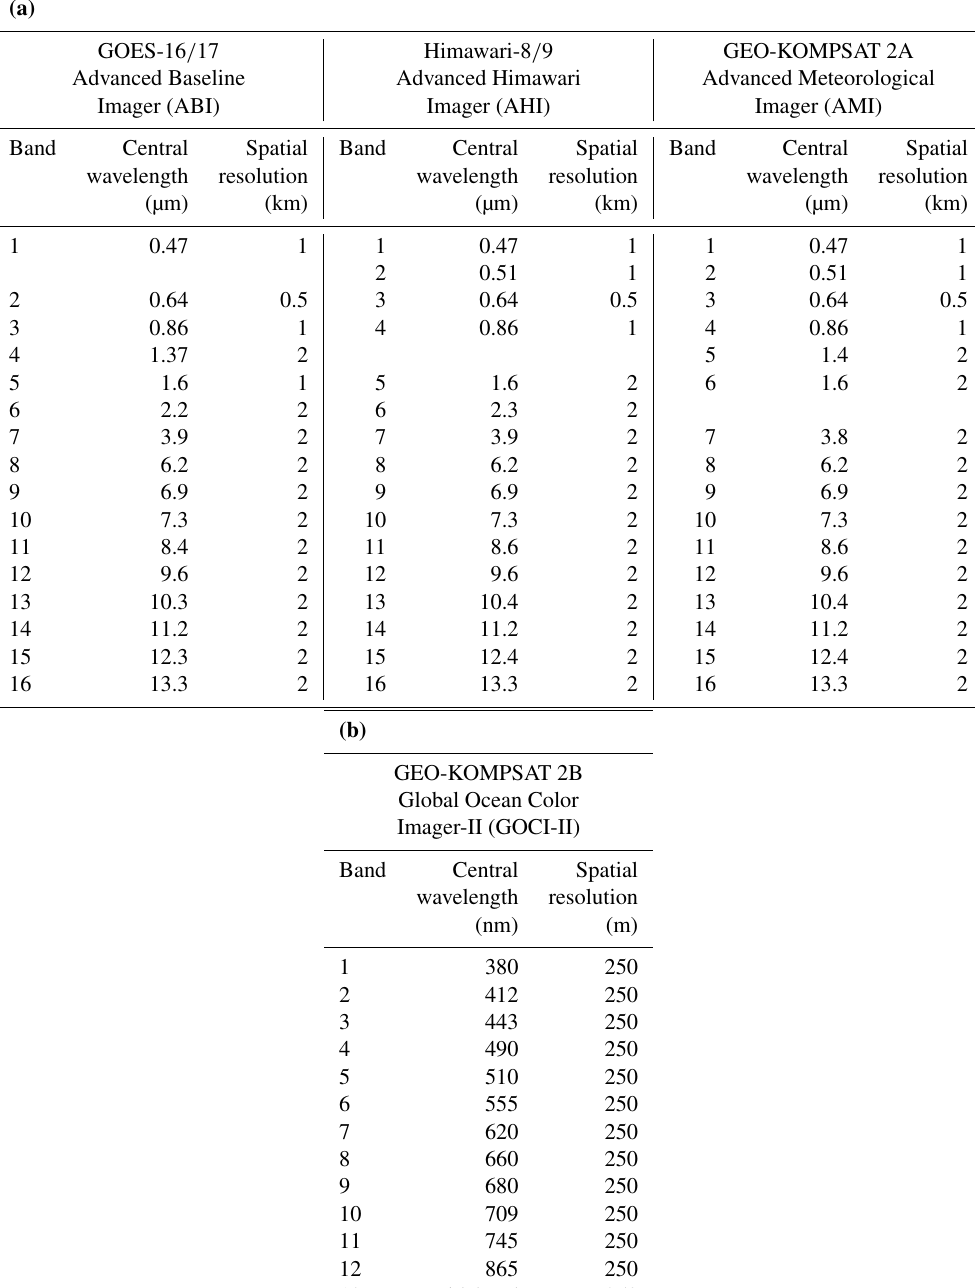
Table 1. Instrument characteristics for the GOES-R Advanced Baseline Imager, Advanced Himawari Imager on Himawari-8 / 9, and the Advanced Meteorological Imager on the Geostationary – Korea Multi-Purpose Satellite-2 (GEO-KOMPSAT-2A) (a) and the Global